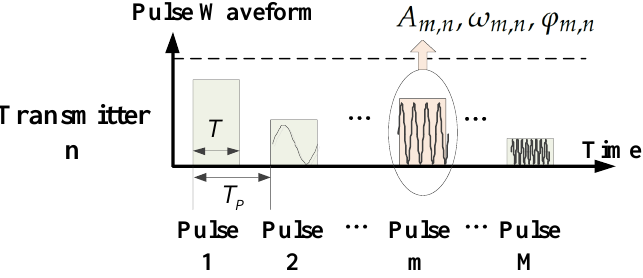
Figure 2. Excitation Waveforms of the n -th